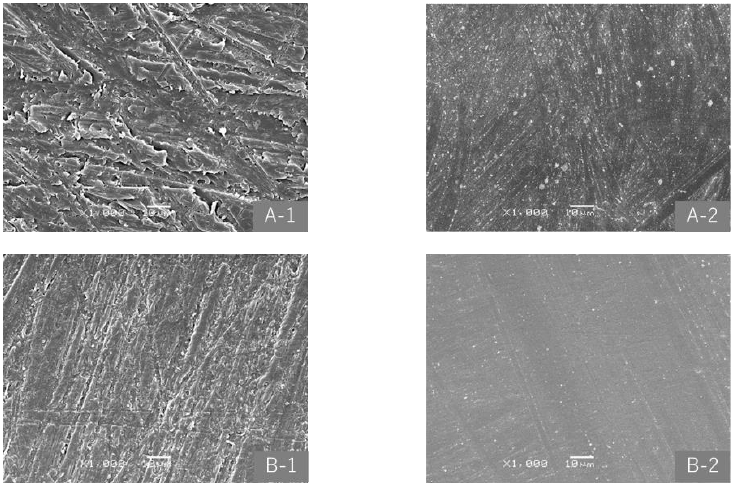
Figure 3. SEM images (×1000) before and after SBVM polishing. ( A-1 ) 400-grit specimen before polishing; ( A-2 ) 400-grit specimen after polishing; ( B-1 ) 1500-grit specimen before polishing; and ( B-2 ) 1500-grit specimen after polishing.